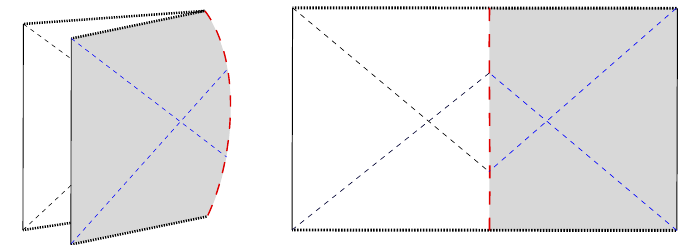
Figure 4 . The maximally extended Penrose diagram of the spacetime after inception. The real black hole spacetime (white) terminates at the EOW brane (red dashed line), then holographic inception creates the region behind (gray). The inception region also contains a black hole, due to the entanglement in the state (2.1). Left: since we glue convex-to-convex, we need to imagine the diagram as a folded piece of paper. Right: the causal structure is better visualized when we unfold the diagram. Note that a conventional convex-to-concave gluing would not lead to a long wormhole: it would require us to delete the other side of the brane in the inception